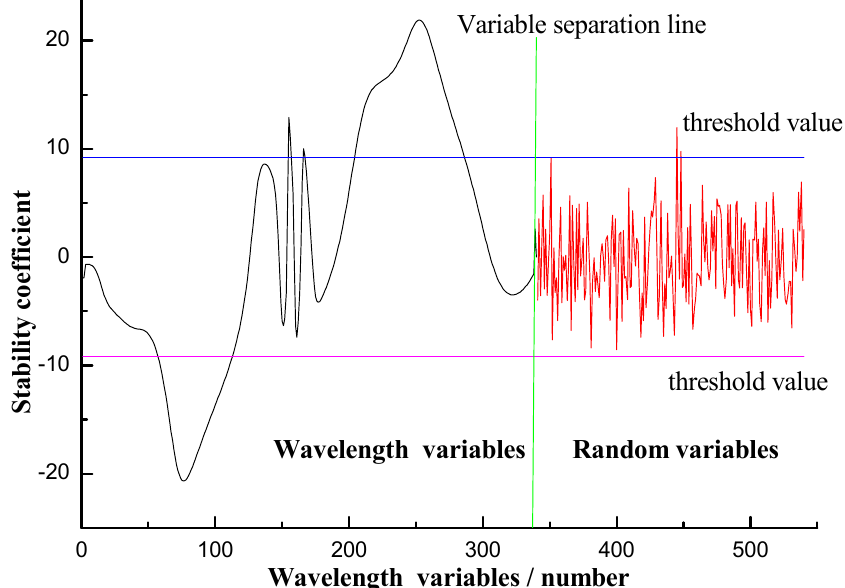
Figure 7. THz spectral wavelength selection by UVE of benzoic acid aqueous solution samples.